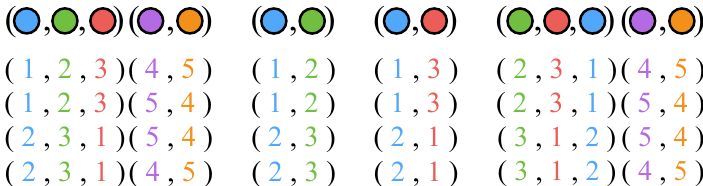
, the same featured in example (B.12c). All rep- 5